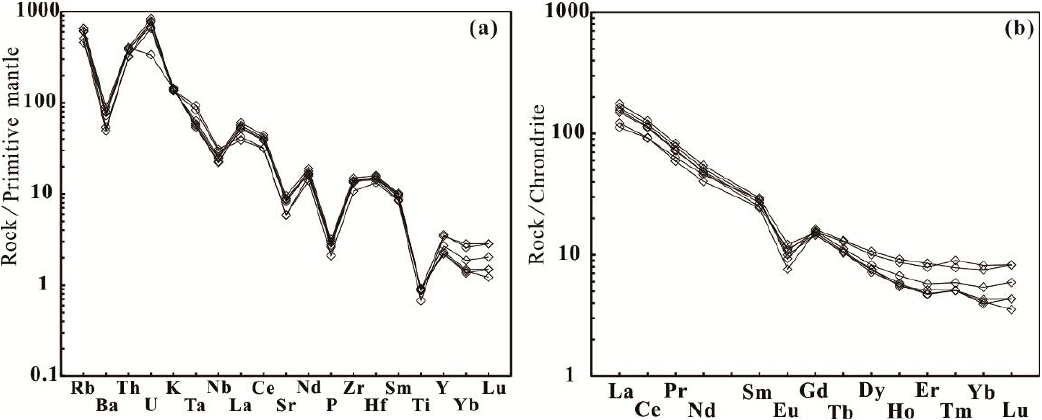
Figure 7. Primitive mantle-normalized trace element spider diagram ( a ) and chondrite-normalized REE diagram ( b ) for the MG from the Wulandele Mo deposit. The primitive mantle data are from [21], the chondrite-normalized data are from [22].